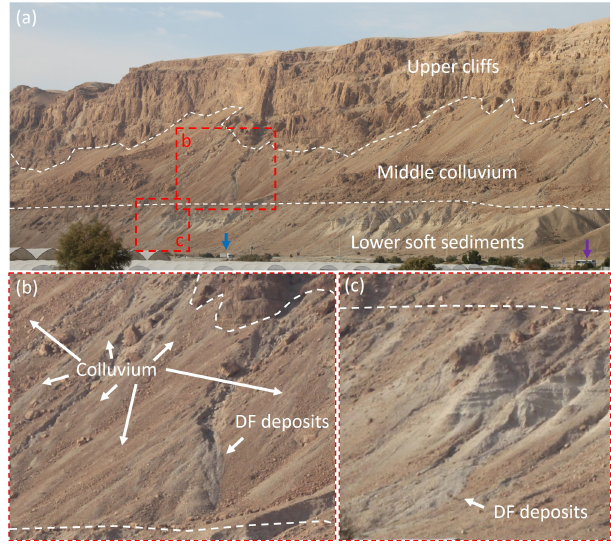
Figure 2. The studied escarpment and the observed DF deposits. (a) The northern part of the study area where group 1 DFs were observed. The escarpment is generally divided into three parts: the upper cliffs, middle colluvium and lower soft sediments. A truck and a bus are marked for scale by blue and purple arrows, respec- tively. The extents of the zoomed-in photos are marked by red rect- angles. (b) A section of the middle colluvium part of the escarp- ment. Colluvium cover (some are pointed out by white arrows) with some large boulders is cut by small ephemeral streams that end with DF deposits. The source material is usually clearly seen in the col- luvium above these deposits. (c) A DF lobe at the end of a short ephemeral stream. The deposits source from the light-color lacus- trine